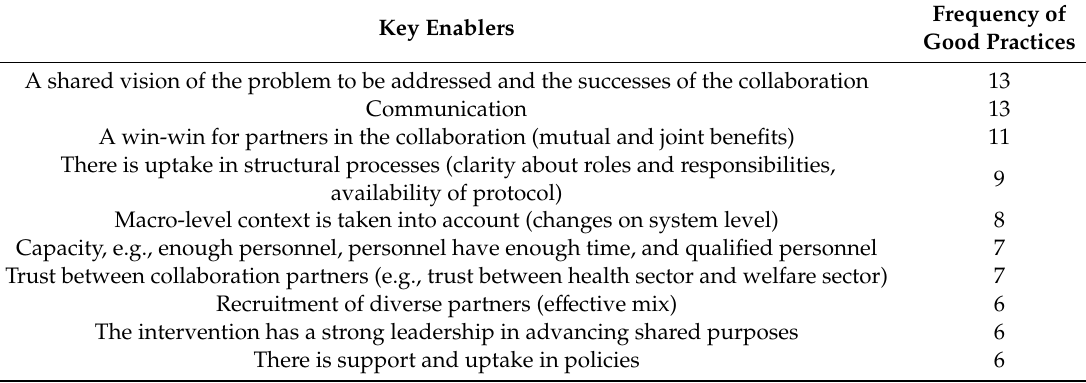
Table 2. Top 10 intersectoral collaboration enablers according to the CHRODIS-PLUS Work Package 5 Partner Online Survey.